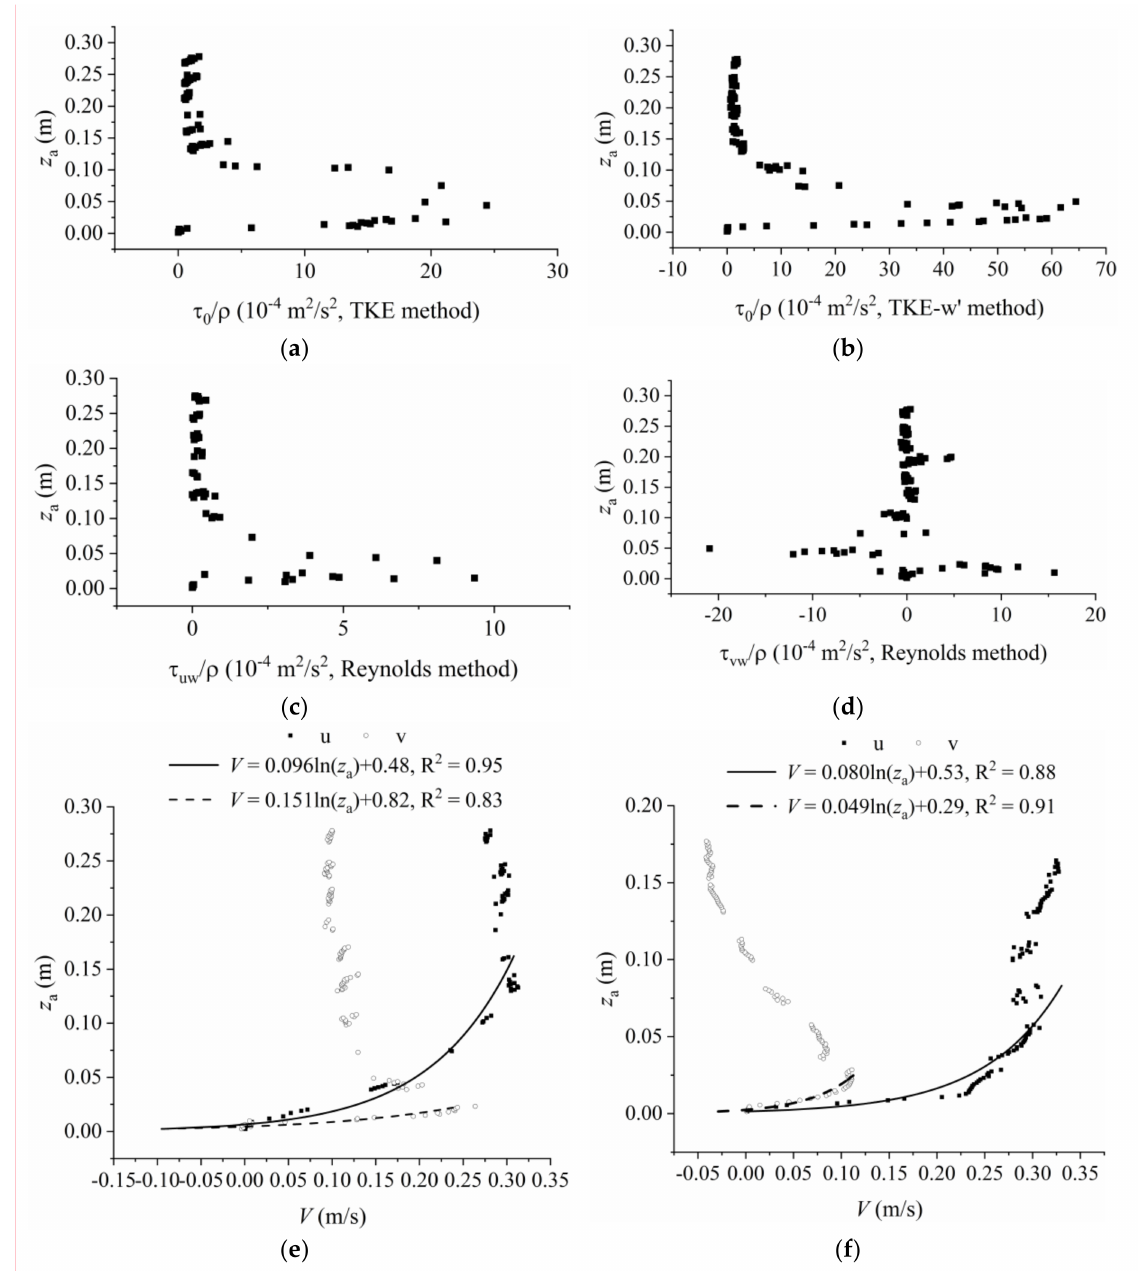
Figure 3. Bed shear stress estimates: ( a ) TKE method ( n / L = 1.4, S 29); ( b ) TKE-w (cid:48) method ( n / L = 1.4, S 29); ( c ) Reynolds method ( n / L = 1.4, S 29); ( d ) Reynolds method ( n / L = 1.4, S 29); ( e ) log-law method ( n / L = 1.4, S 29); ( f ) log-law method ( n / L = 4.8, S